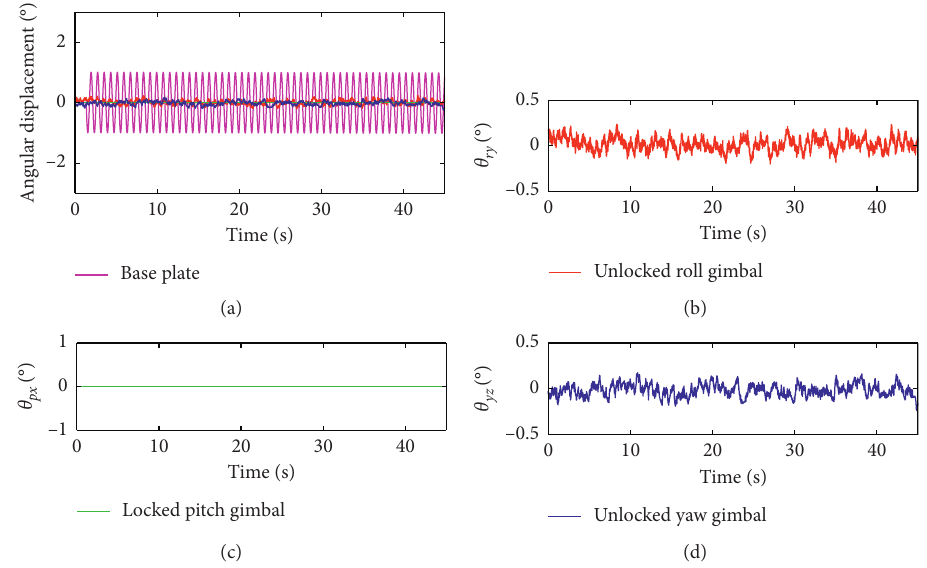
Figure 15: Angular displacements of (a) base plate, (b) roll gimbal, (c) pitch gimbal, and (d) yaw gimbal with two unlocked gimbals.